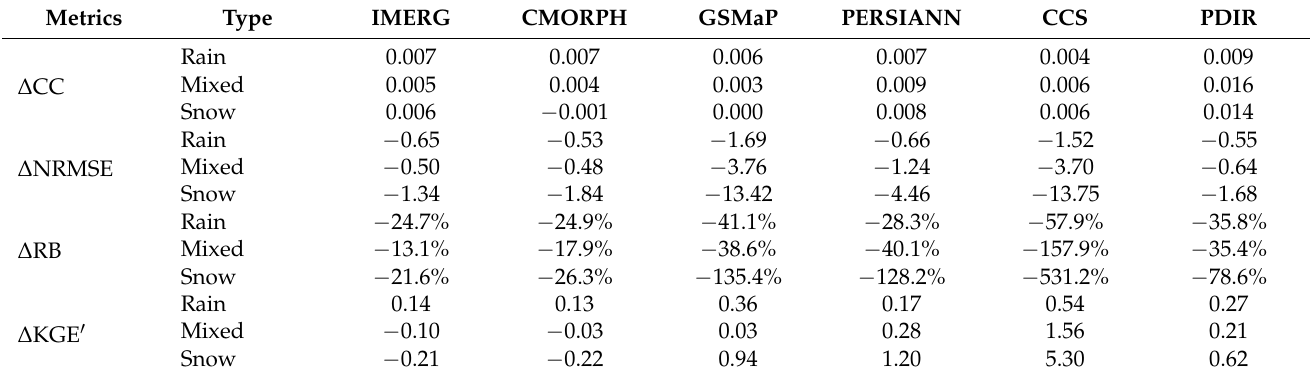
Table 5. The changes of continuous metrics of six SPPs for different precipitation phases.